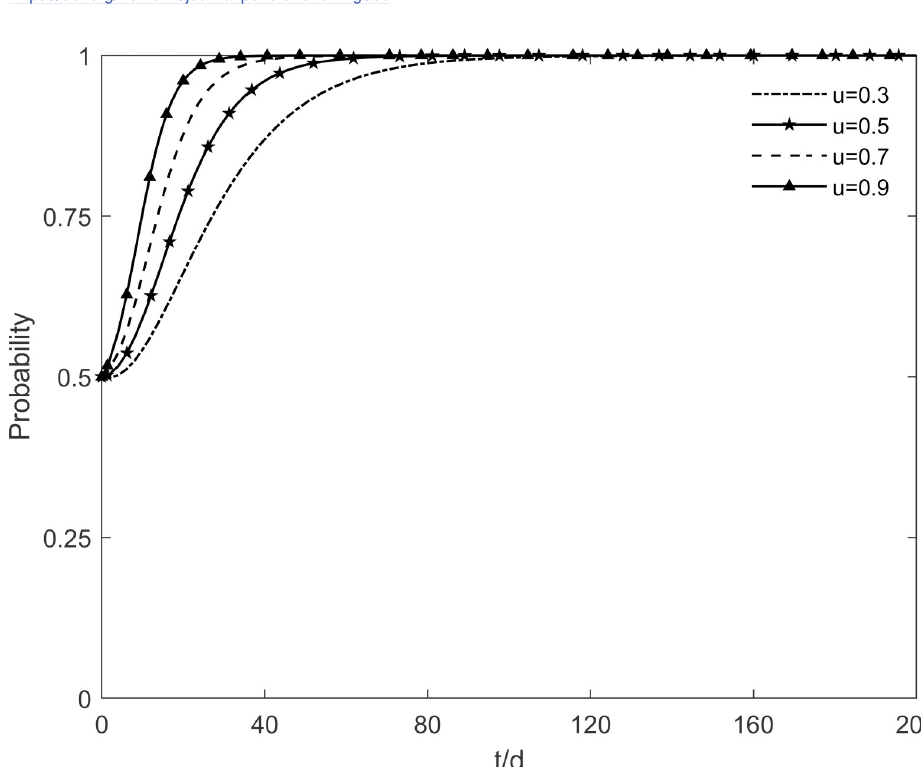
Fig 7. The impact of u on the investment retrofitting enterprises’ strategic choices.